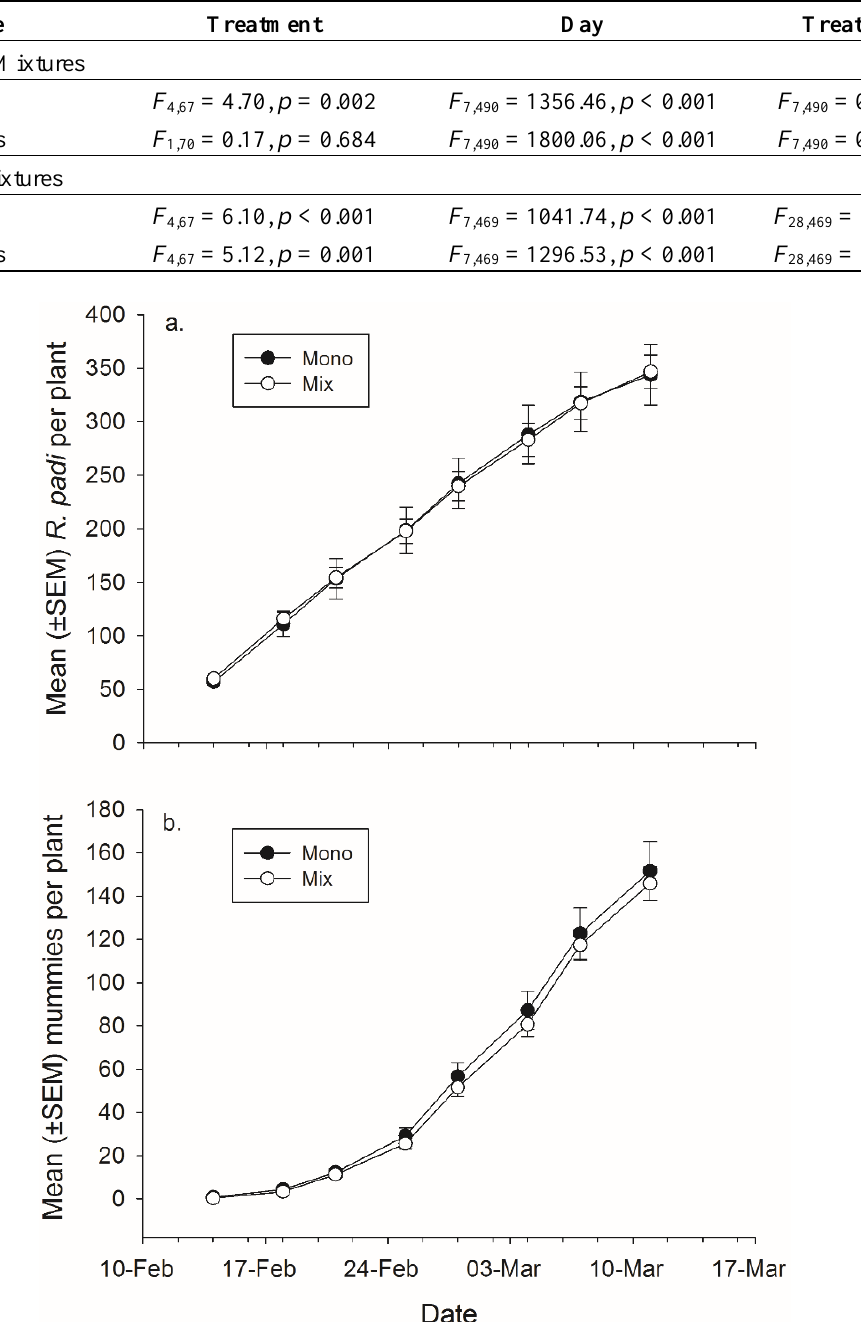
Figure 4. Mean (± SEM) total number of ( a ) R. padi produced and ( b ) mummies produced in monoculture and mixture grain pots on each data collection